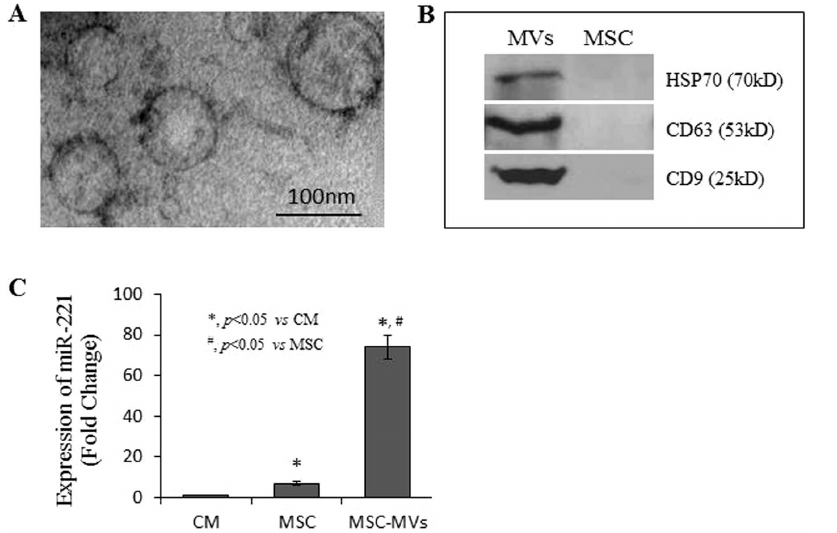
Figure 7. The morphology and characterization of MSC derived MVs (MSC-MVs). Panel A: Morphological features of MSC-MVs under electron microscope. Panel B: Western blot results show that MSC-MVs highly expressed HSP70, CD63, and CD9 compared to MSC; Panel C: The expression of miR-221 in MSC-MVs, MSC, and CM analyzed using real-time PCR.